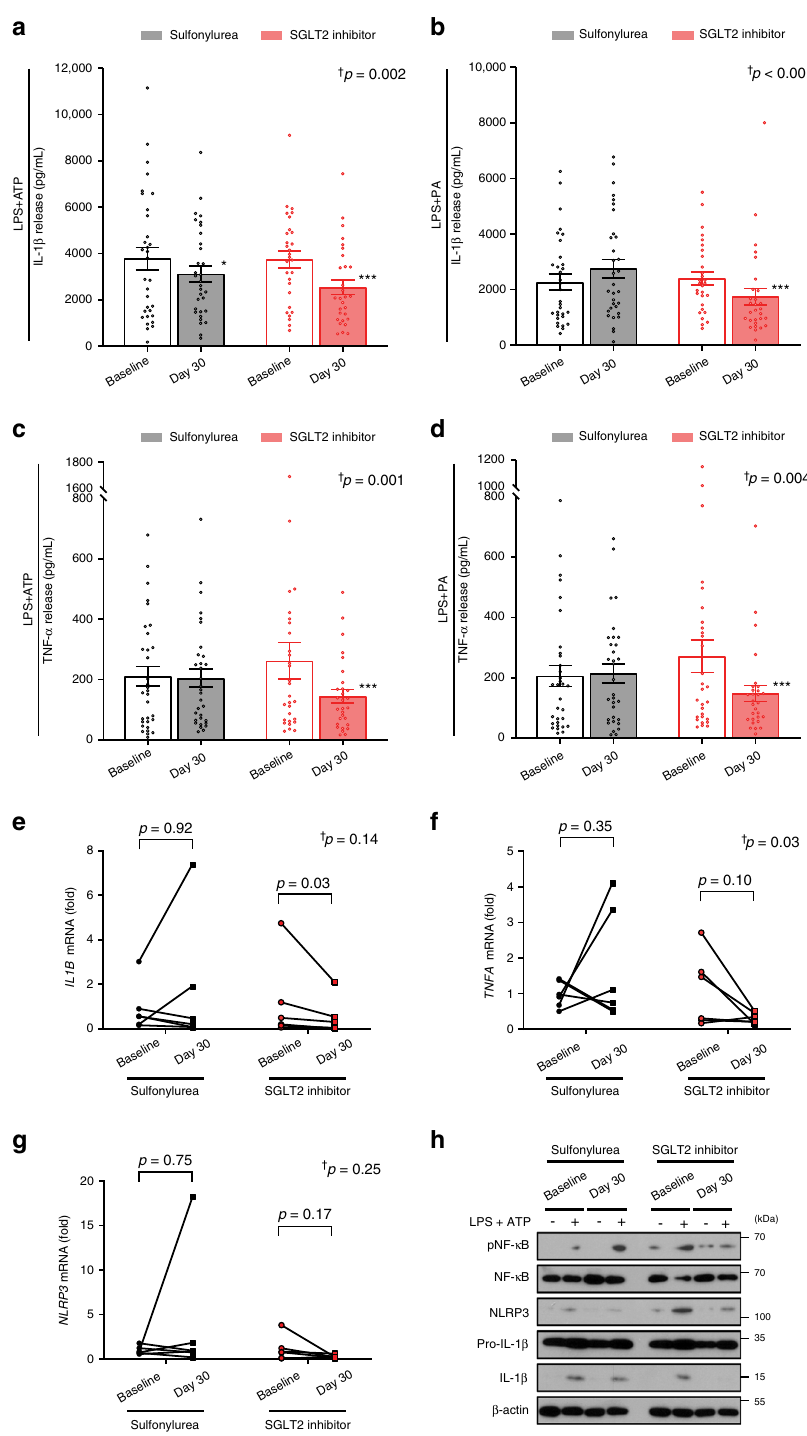
Fig. 3 Effects of SGLT2 inhibitor and sulfonylurea on secretion of IL-1 β and TNF- α from macrophages. ELISA assay measurement of IL-1 β secretion from macrophages exposed to 2mM ATP ( a ) or 0.2mM palmitate ( b ) with 0.1 μ g/mL LPS priming (sulfonylurea group: n = 32, SGLT2 inhibitor group: n = 29). TNF- α secretion from macrophages exposed to ATP ( c ) or palmitate ( d ). Experiments were repeated twice or three times per sample; bar graphs are drawn using mean values of those results per sample, whereas the statistical signi fi cances are derived from raw data. Data are represented as mean ± SEM. Two-sided paired t test; * P <0.05, ** P <0.01, and *** P <0.001 versus baseline. mRNA levels encoding IL1B ( e ), TNFA ( f ), and NLRP3 ( g ) ( n = 6 per group). Two-sided paired t test or Wilcoxon signed rank test. † Statistical signi fi cance for the time×group interaction evaluated by repeat-measures analysis of variance (ANOVA) (Non-normally distributed variables were log transformed for analysis and back transformed for presentation). h Representative protein levels of molecules regarding NLRP3 in fl ammasome activation with or without LPS and ATP stimulation. IL-1 β interleukin-1 β , NF- κ B nuclear factor kappa-light-chain-enhancer of activated B cells, NLRP3 NLR family, pyrin domain-containing 3, PA palmitate, SEM standard error of the mean, SGLT2 sodium – glucose cotransporter 2, TNF- α tumor necrosis factor- α . Source data are provided as a Source Data fi